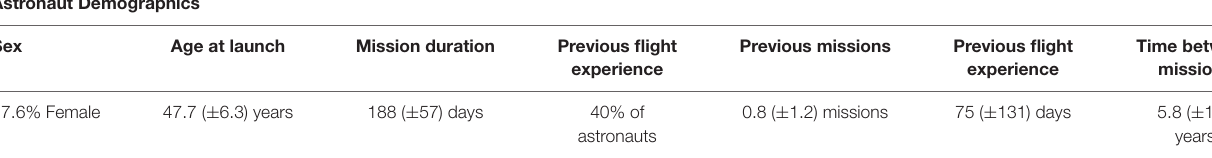
TABLE 1 | Astronaut demographics. Astronaut